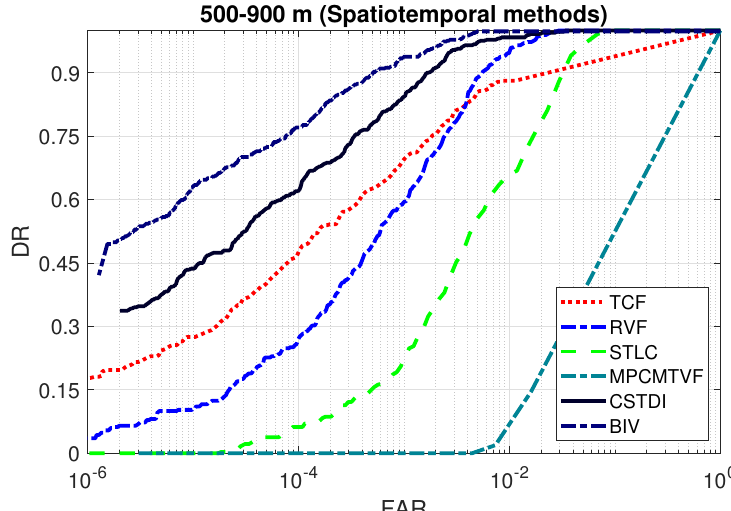
Figure 9. ROC curves comparison: spatiotemporal methods (logarithmic x-axis). Existing methods are outperformed by the BIV target detector on the combined range showing that the improved response of the BIV model is not due to overfitting of parameters for each range.